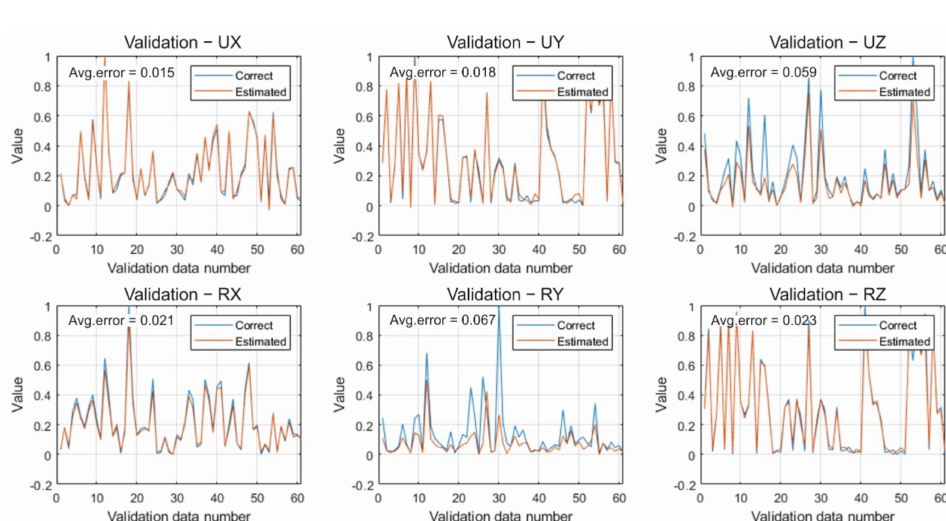
Figure 17. Validation